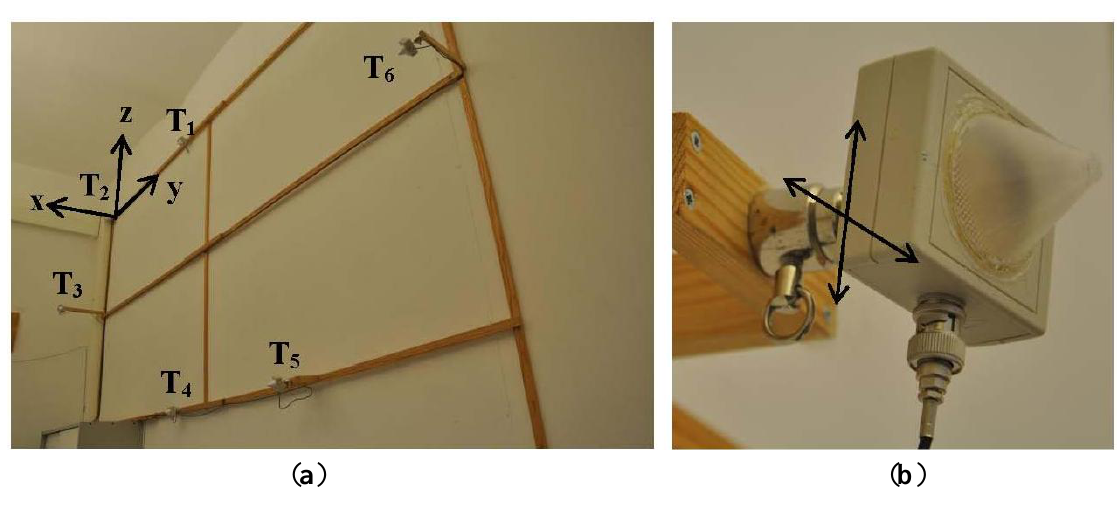
Figure 12. Activation unit consisting of high voltage (HV) amplifier, demultiplexer and